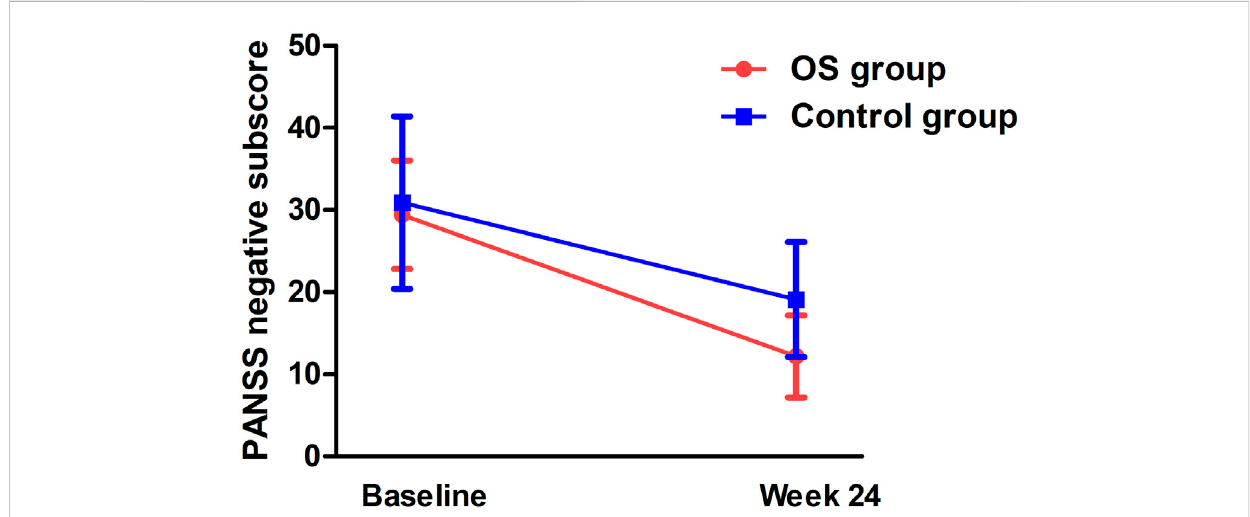
FIGURE 2 Interaction effect of group and time on negative symptoms in TRS patients ( p <